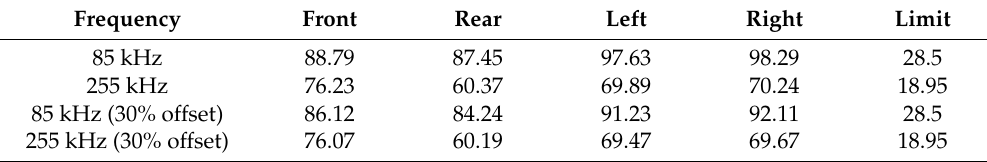
Table 9. Magnetic field strength at three meters around the